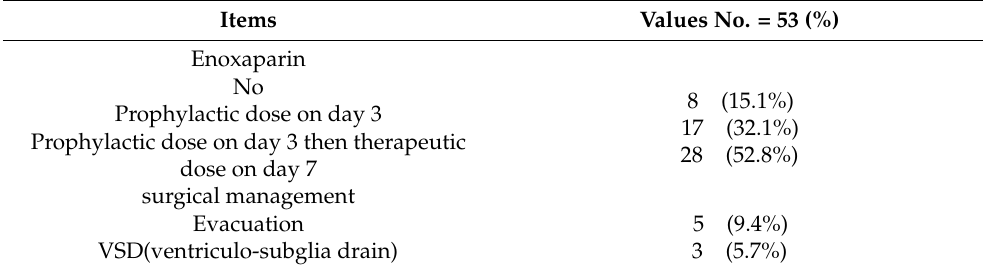
Table 3. Management of the studied patients regarding their COVID-19 disease and neurosurgi- cal management.